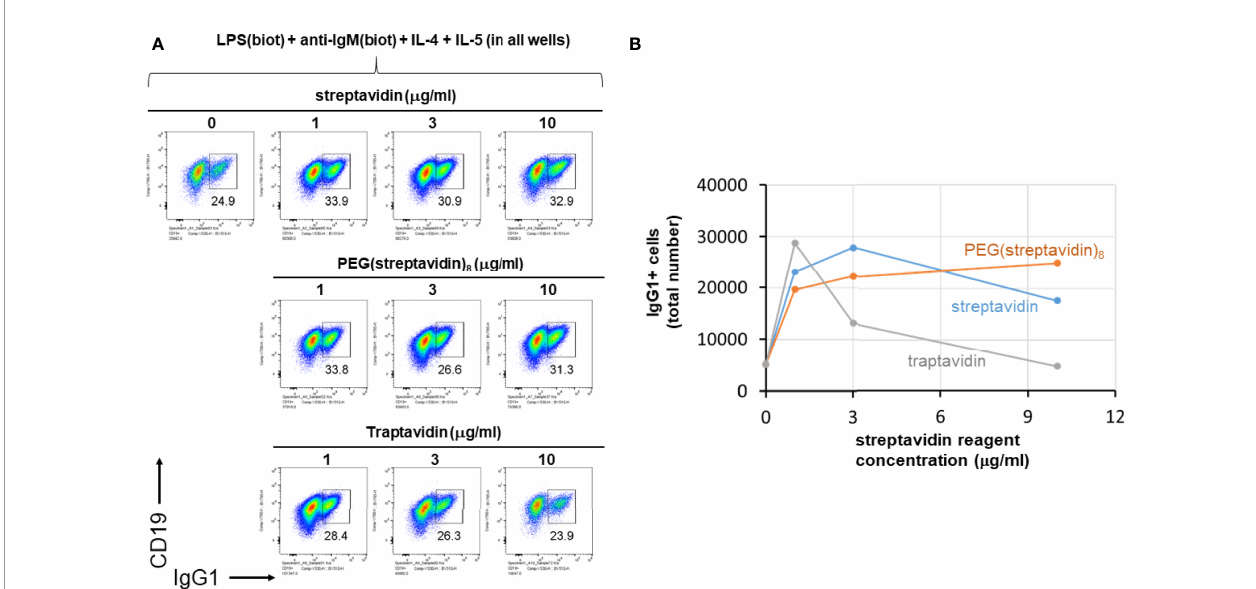
FIGURE 5 | Streptavidin, PEG(streptavidin)8 or traptavidin enhance B cell growth and CSR. LPS(biotin) (2 m g/ml) and anti-IgM F(ab ’ ) 2 (0.3 m g/ml) biotin-LPS were incubated with the indicated amounts of streptavidin, PEG(streptavidin)8, or traptavidin in the wells of a V-bottom polypropylene plate for 2 hrs at rt (all wells also contained 50 ng/ml IL-4 and 50 ng/ml IL-5). Each well was then added to the corresponding well of resting murine splenocytes (1.5 x 10 5 cells/ml in each well) in RPMI-FBS plus BME containing. After 4 days in culture, cells were analyzed by fl ow cytometry. (A) The growth of B cells visualized by the typical forward vs side scattering indicates better growth at intermediate streptavidin:biotin conjugate ratios. (B) Quanti fi cation of the total number of IgG1+ B cells per well for each of the avidin reagent concentrations shown in (A)